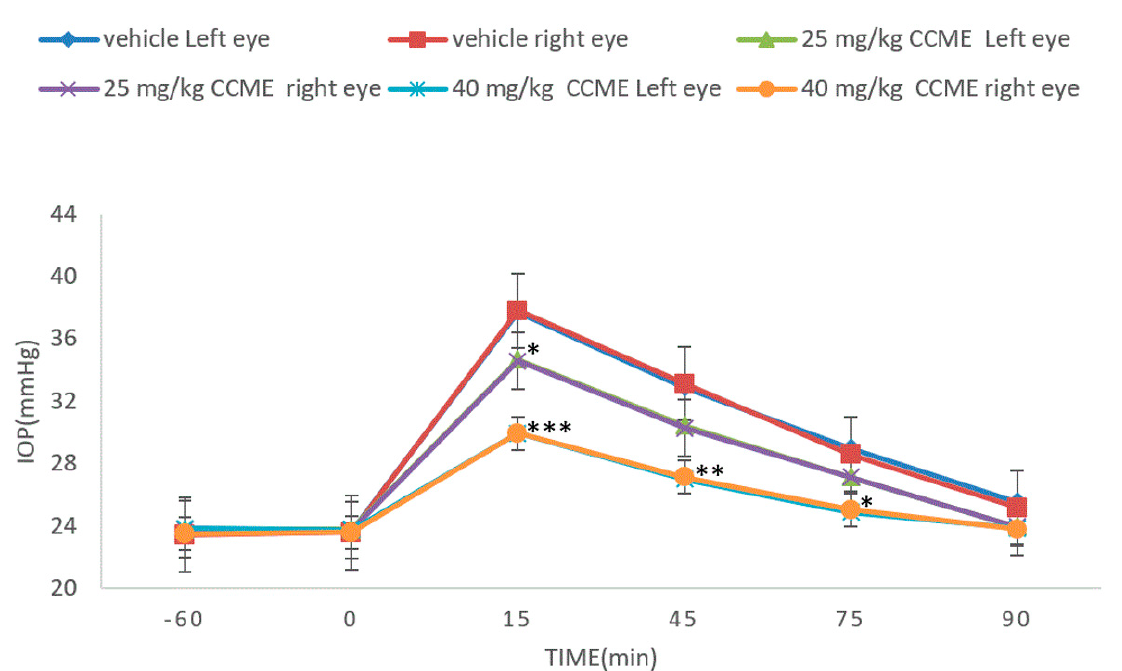
Figure 5. Anti-hypertensive effect of C. cicadae mycelia extract (CCME) in dextrose-induced acute glaucoma rabbit (A45—25 mg/kg/b.w.; B—40 mg/kg/b.w.) n = 4, mean ± SEM. * p < 0.05, ** p < 0.01 and *** p < 0.001, compared with solvent control group.